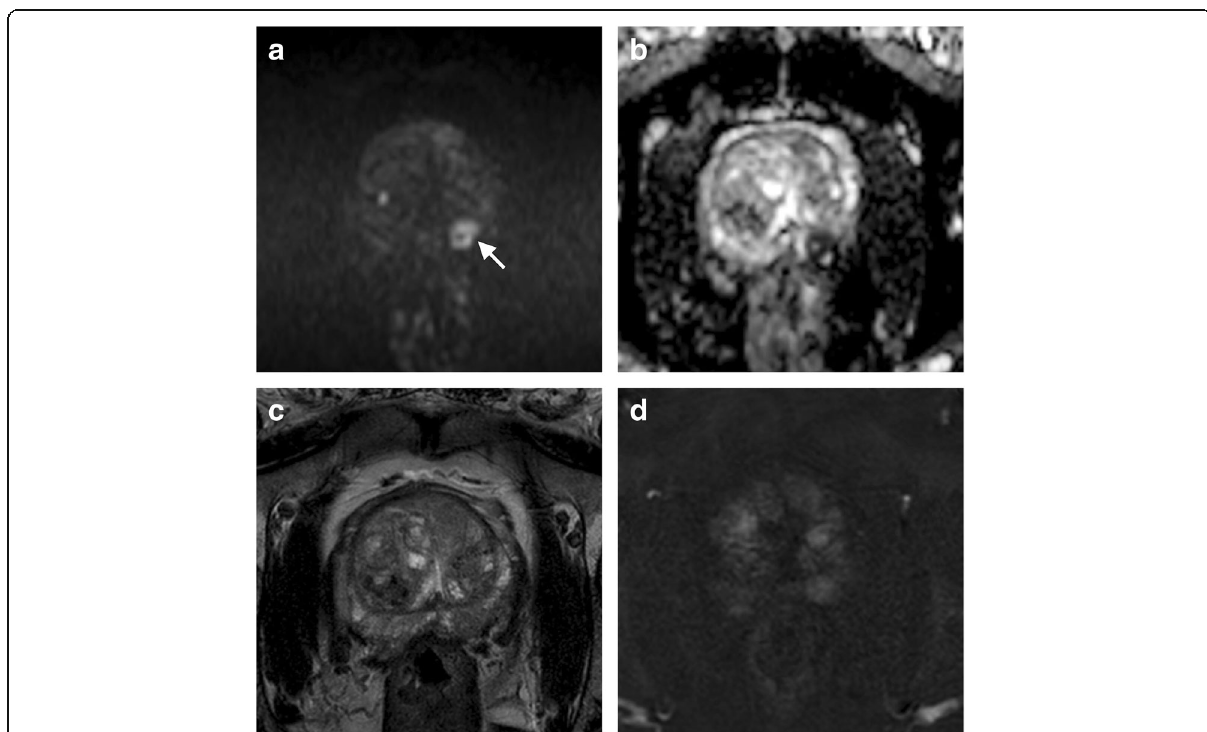
Fig. 1 Application of the Prostate Imaging Reporting and Data System (PI-RADS) version 2 in interpreting a finding in the peripheral zone (PZ) of a biopsy-naïve 62-year-old man undergoing prostate multiparametric magnetic resonance imaging (mpMRI) for elevated prostate specific antigen (PSA) level. The dominant sequence, i.e. , a transverse diffusion-weighted imaging (DWI) sequence, showed an area (< 15 mm in size) of restricted water diffusion in the left midgland PZ, as testified by high signal intensity on the b = 2000 s/mm 2 image (arrow in a ) and corresponding marked hypointensity on the apparent diffusion coefficient (ADC) map ( b ). This finding was classified as PI-RADS 4 accordingly, with additional ancillary suspicious features such as hypointensity on transverse T2-weighted imaging ( c ) and focal early contrast enhancement on subtracted T1-weighted imaging ( d ). Pathology after radical prostatectomy found a Gleason score 7 (3 + 4) T3a N0